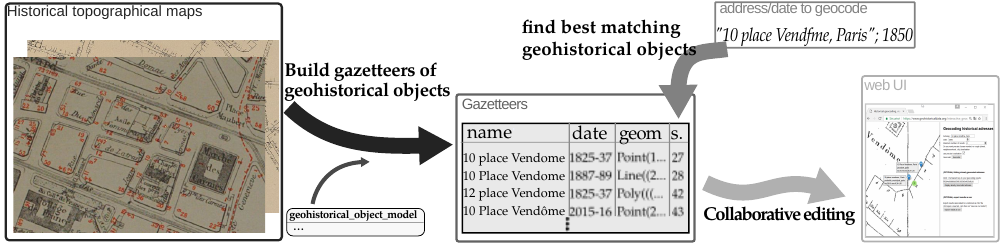
Figure 2. Gazetteers of geohistorical objects are created based on information extracted from georeferenced historical maps. Geocoding a historical address means finding the best-matching object in these gazetteers, based on a customised function (semantic, temporal aspect, spatial precision, etc.). Results can be displayed through a dedicated web interface for collaborative